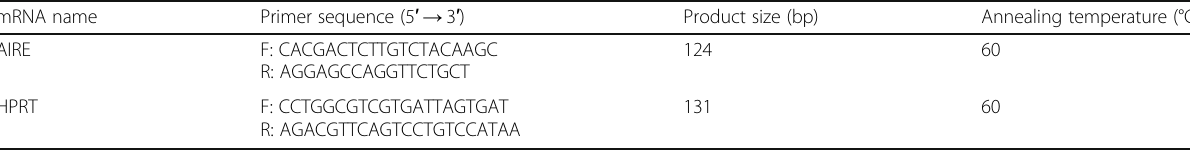
Table 3 Primer sequences and PCR conditions for the real-time PCR of AIRE mRNA mRNA